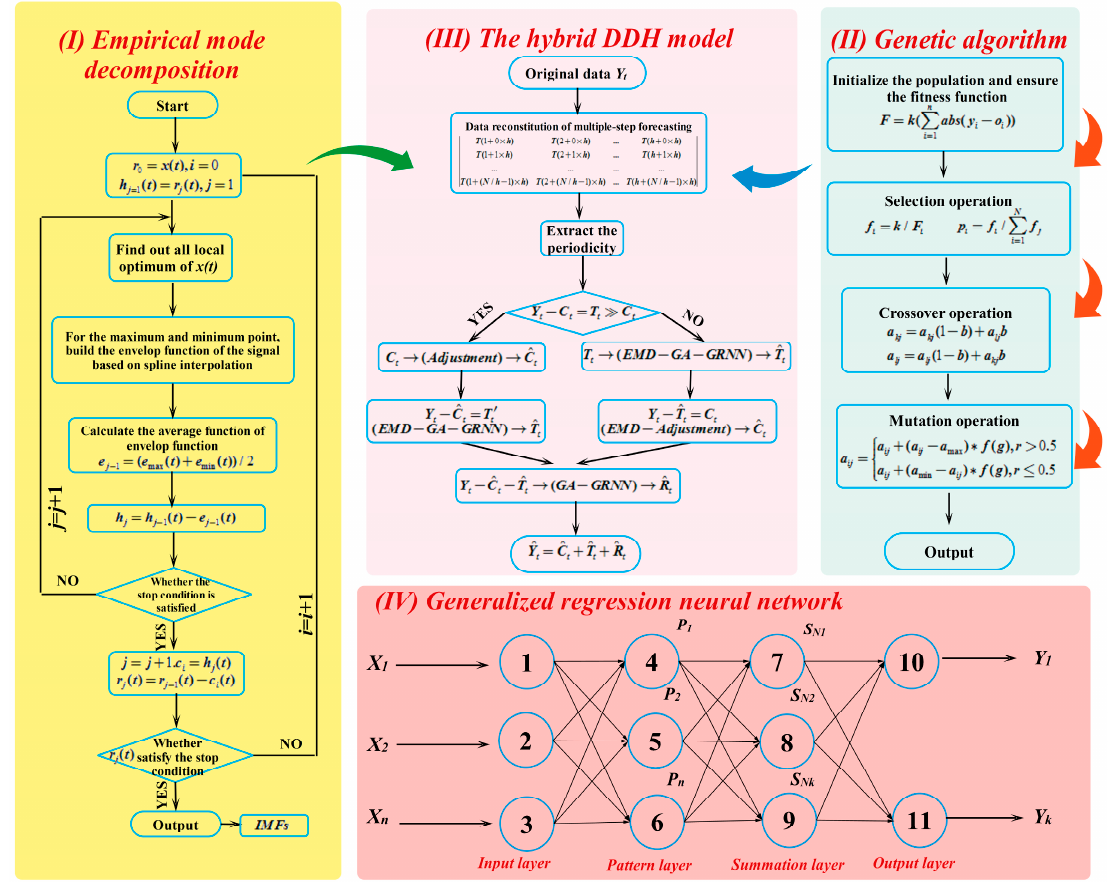
Figure 1. Steps of the main methods and proposed hybrid model in this paper. Algorithm 1: Pseudo code of Empirical Mode Decomposition —a sequence of sample data. —a sequence of denoising data.